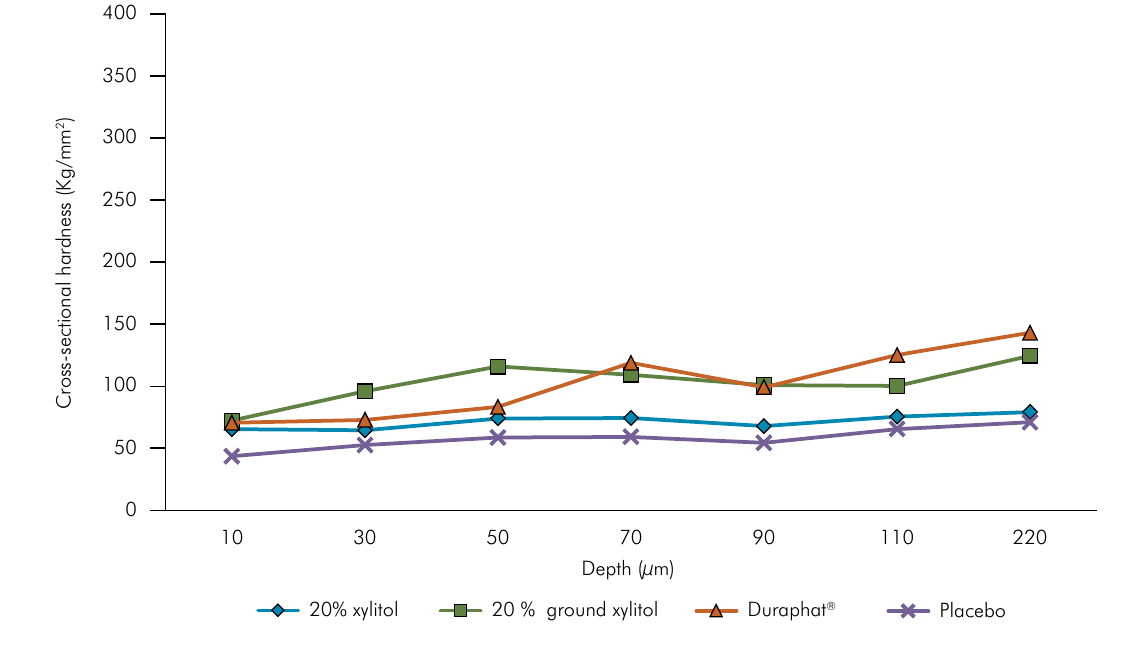
Figure 2. Subsurface hardness (kg/mm 2 ) at the different depths of the experimental groups for the deciduous teeth in vitro